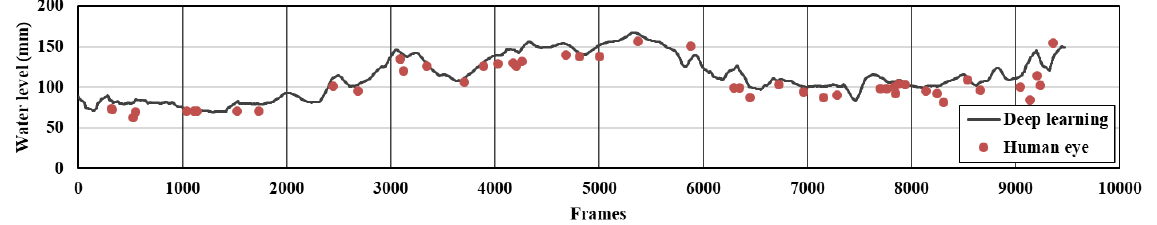
Figure 6. Comparison of the results of observations by the human eye and analysis by deep learn- ing.